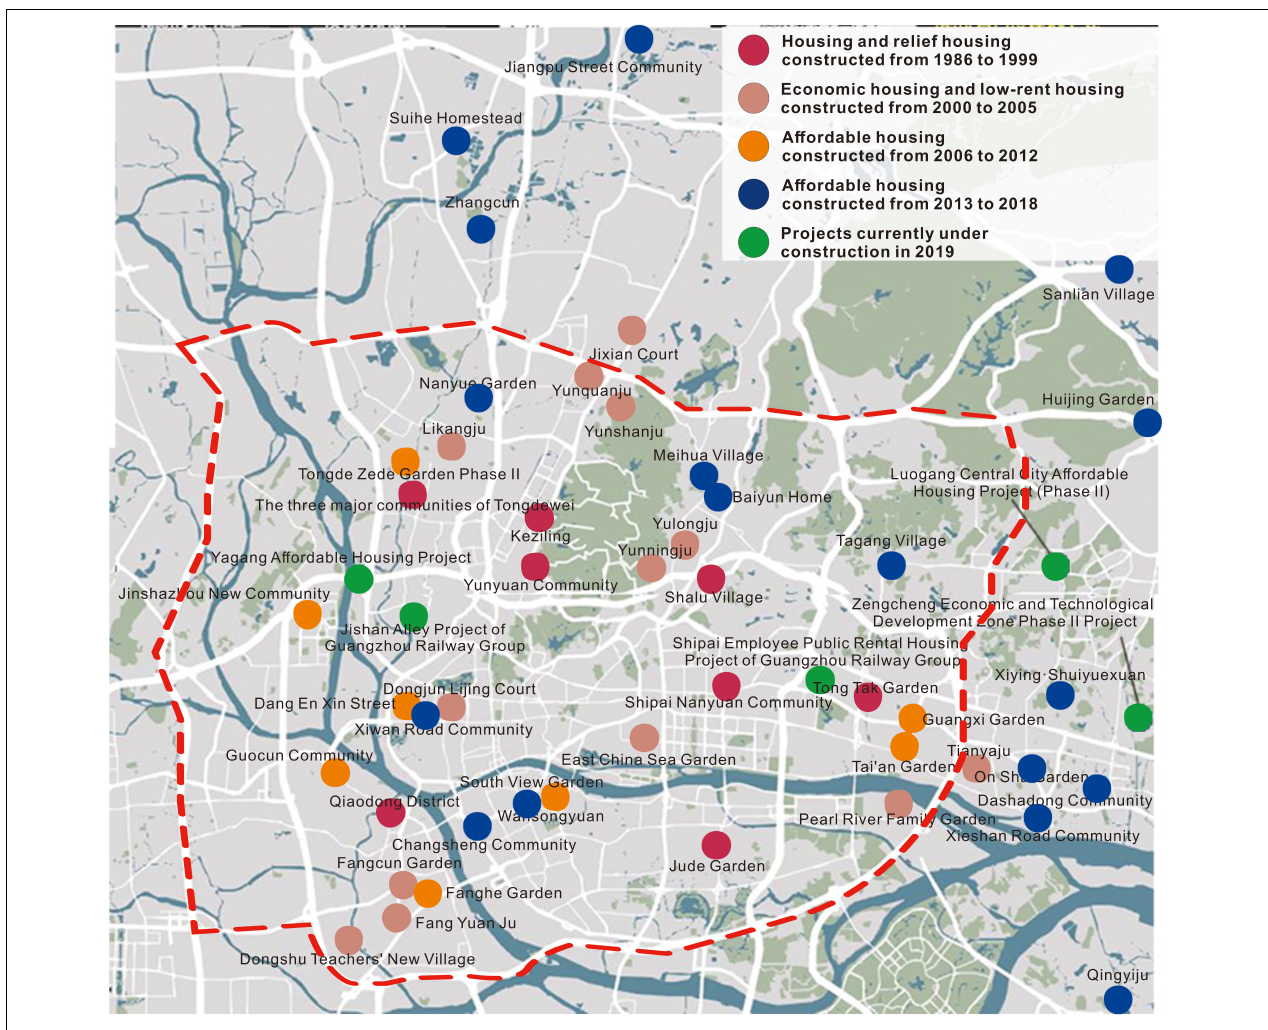
FIGURE 1 | Distribution of affordable housing in the downtown area of